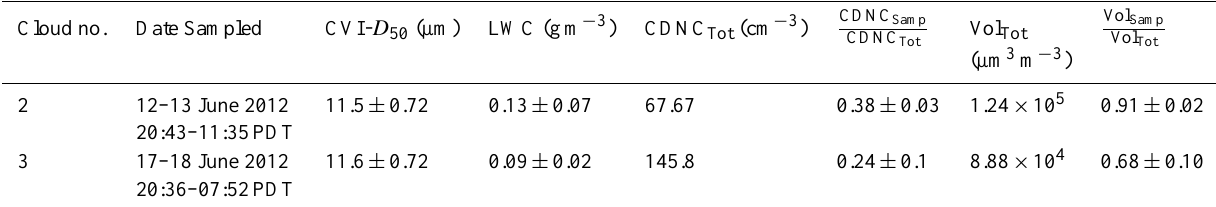
Table 1. Summary of cloud microphysical properties showing the average CVI cut-size (CVI- D 50 ) where the uncertainty stems from the cal- culated cut-size (see text for details); average liquid water content (LWC) and 1 standard deviation; and the cloud droplet number (CDNC Tot ) and volume (Vol Tot ) concentration for droplets with diameters between 2 and 50µm. Also shown are the number (cid:16) Vol (cid:17) Samp fractions of droplets sampled, where CDNC Samp and Vol Samp are the number and volume concentrations, respectively, for the Vol Tot fraction of droplets sampled.